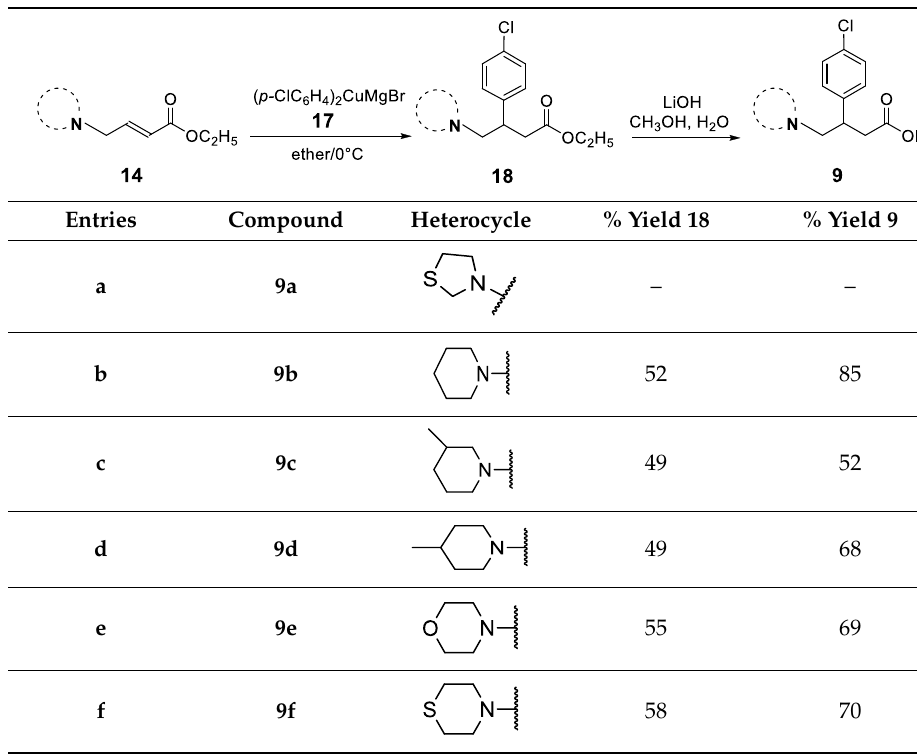
Table 4. Synthesis of the β -substituted analogues 9 .